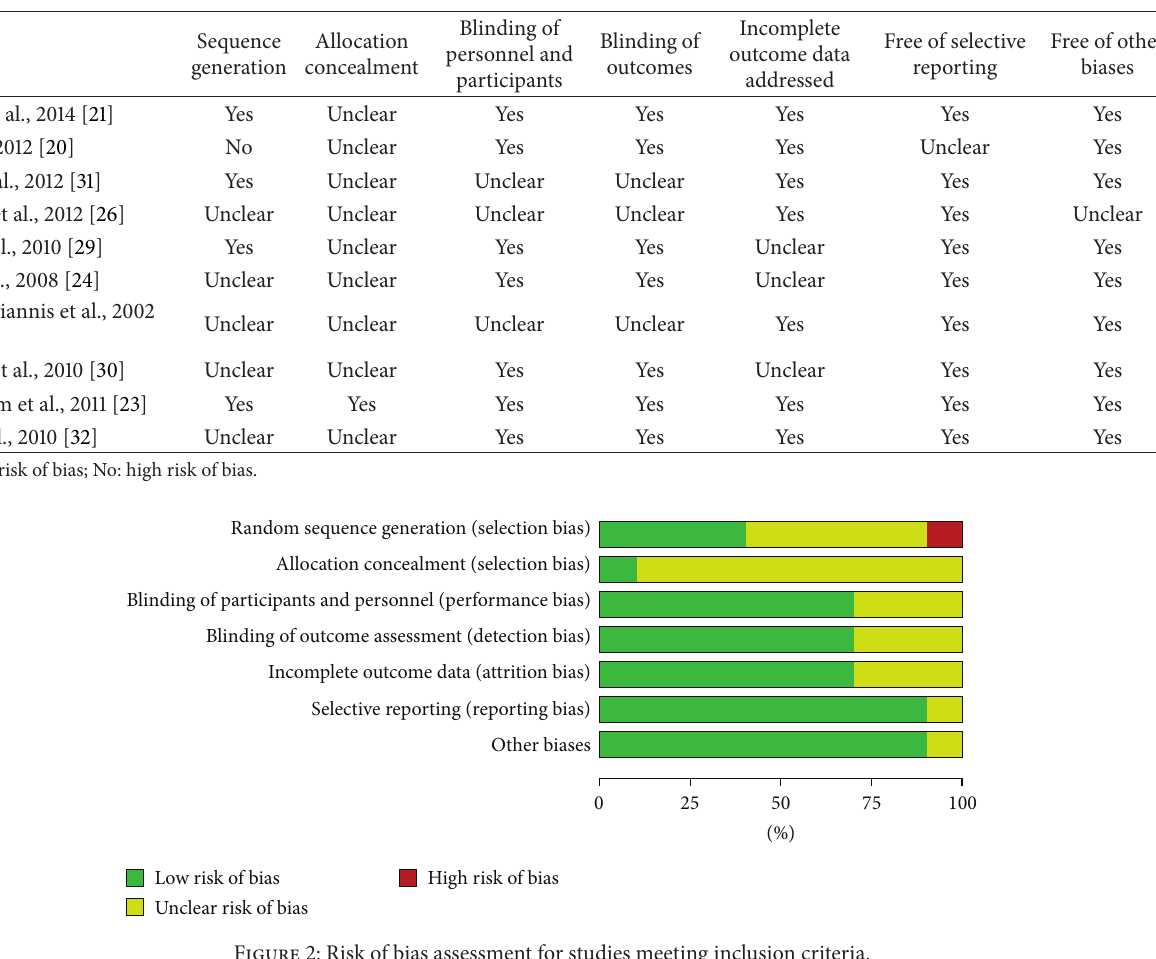
Table 3: Qualitative risk of bias assessment summary.